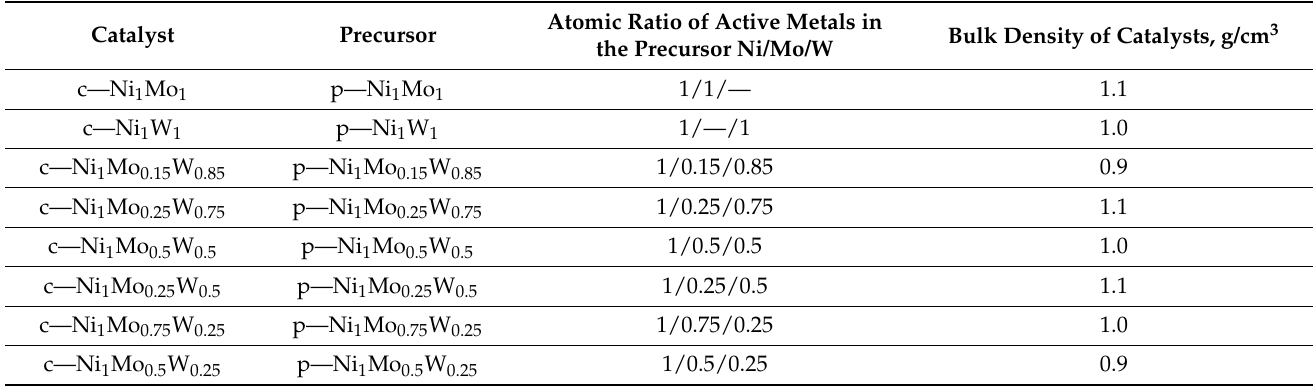
Table 3. Designation and characteristics of catalysts and its